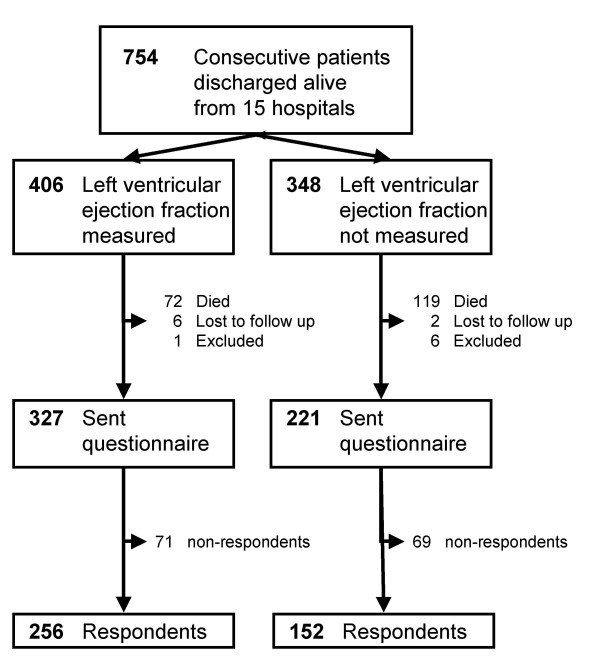
Flow chart of study population. Study population stratified on patients with and without their left ventricular ejection fraction measured